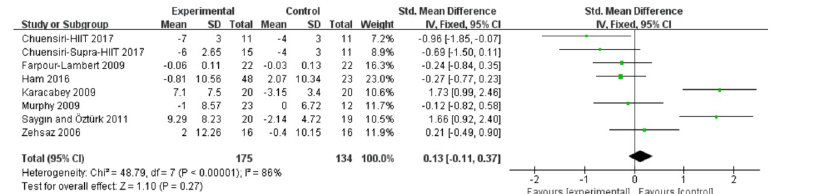
Fig 7. Forest plot of comparison: High-density